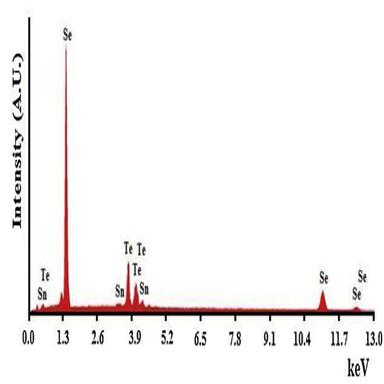
EDX patterns of (a) the unexposed sample (0 kGy) and (b) the exposed sample (12 kGy) of STS ChGA.